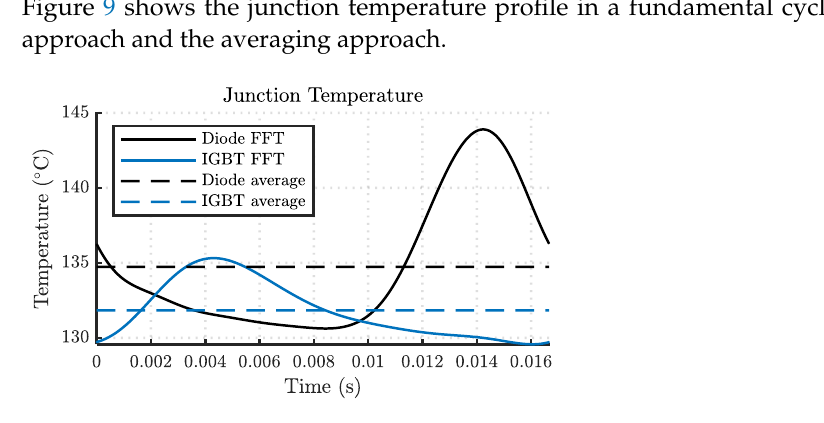
Figure 9. Comparison of the diode and IGBT junction temperatures for one electric cycle (60 Hz) using the FFT approach and the average approach.